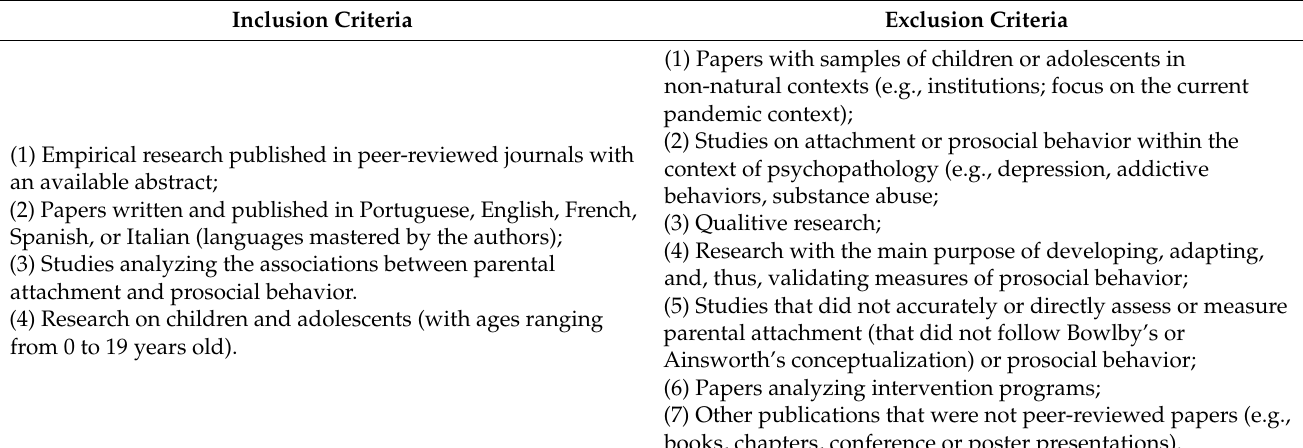
Table 1. Complete list of the inclusion and exclusion criteria